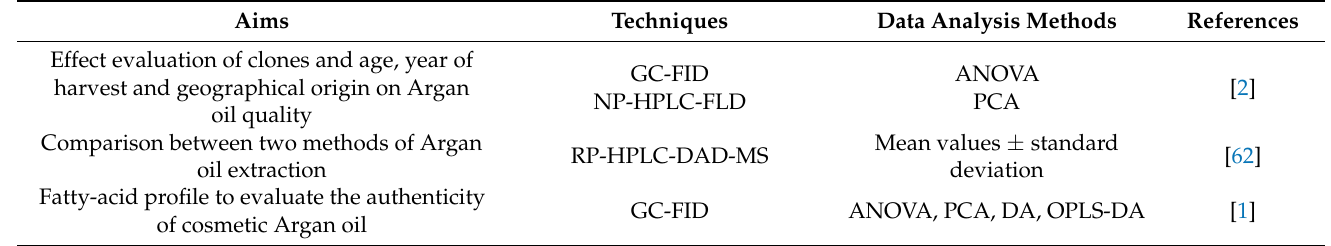
Table 4. Chromatographic techniques for the quality control of Argan oil: targeted analysis. ANOVA: Analysis of Variance; GLM: General Linear Model, NA: not